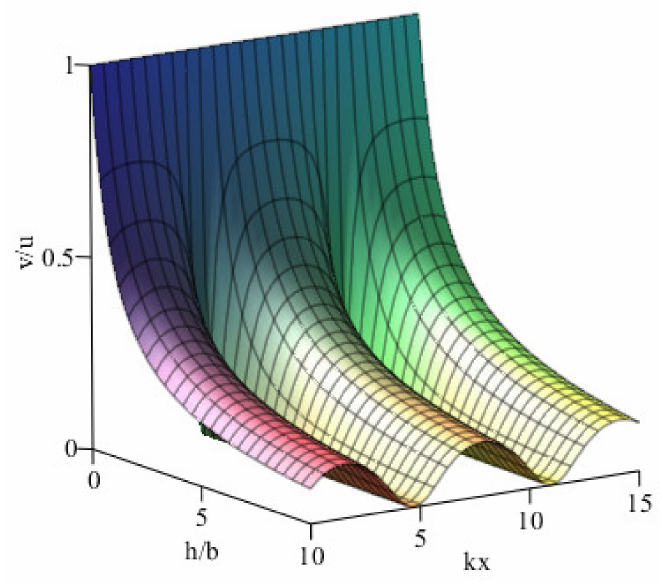
Figure 2. The relative tangential velocity v x / u at z = 0 for b / b = 1 + sin( kx ) at di ff erent h / b